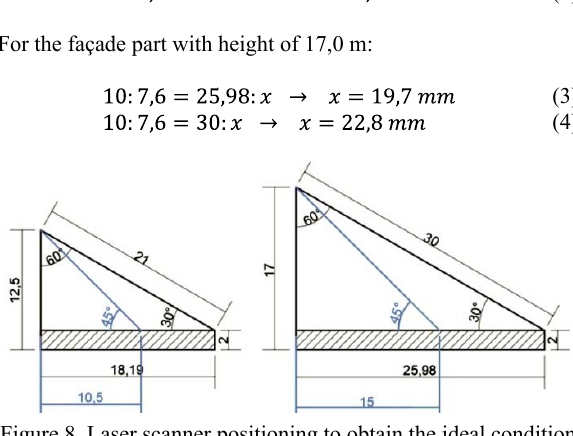
Figure 8. Laser scanner positioning to obtain the ideal condition with a 30° inclined beam on the two different heights in elevation, 12,5 m, and 17 m – graphic elaboration by